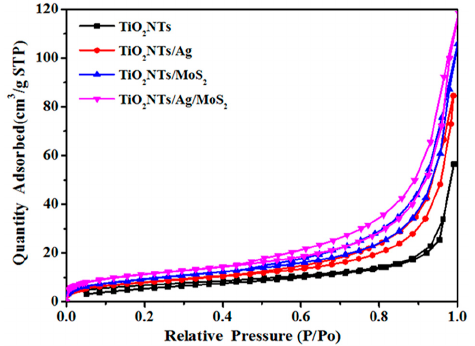
Figure 6 . Nitrogen absorption–desorption isotherms of TiO 2 NTs, TiO 2 NTs/Ag, TiO 2 NTs/MoS 2 , and TiO 2 NTs/Ag/MoS 2 .